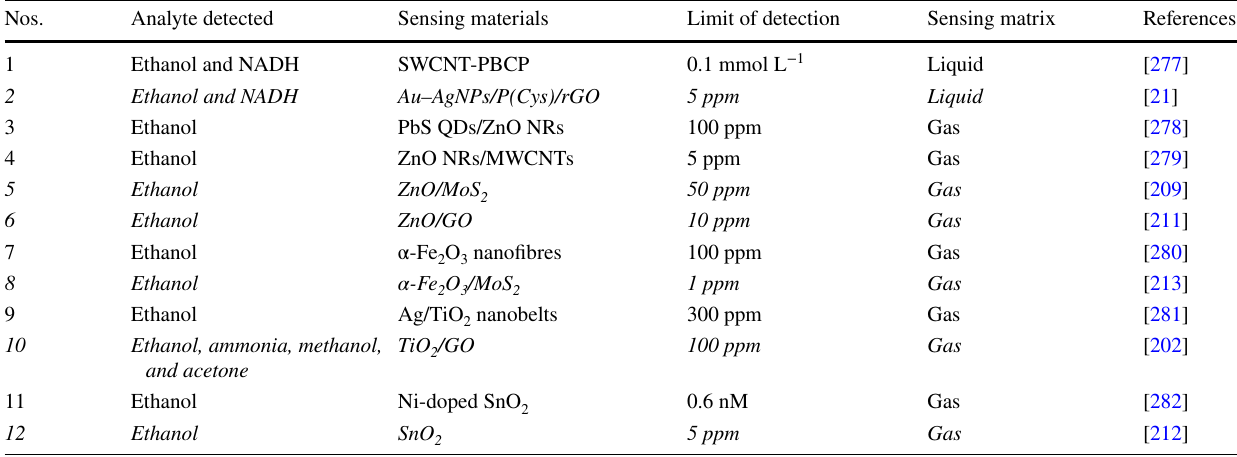
Table 2 Analytical parameters of alcohol nanosensors and biosensors, sorted by LoD and type